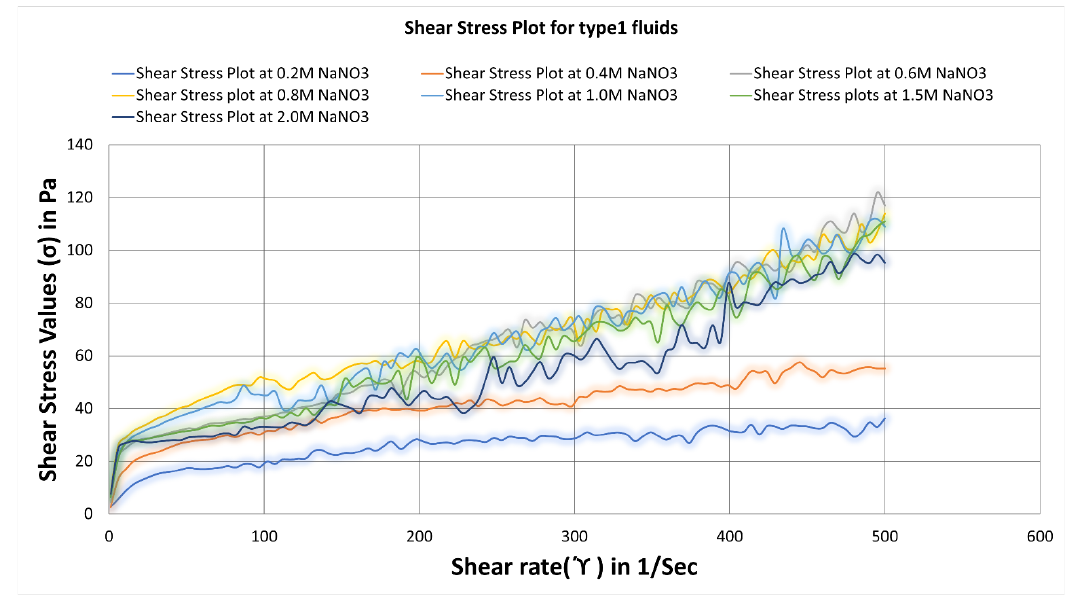
Figure 12. Shear stress vs shear rate curves for surfactant-based viscoelastic fluids of type1 with varying NaNO3 concentrations at 25 °C. Figure 13 depicts shear rate versus shear stress plots based on rheometric analysis data of type2 SBVE fluids with varying NaNO 3 salt concentration at 25 °C. The maxi- Table 3. Yield stress values for type1 fluids at 25 ◦ C. mum yield stress value was 40 Pascal, represented by fluid3 of 0.6 M NaNO 3 concentra- tion, as demonstrated in Table 4. Table 4. Yield stress values for type2 fluids at 25 °C.